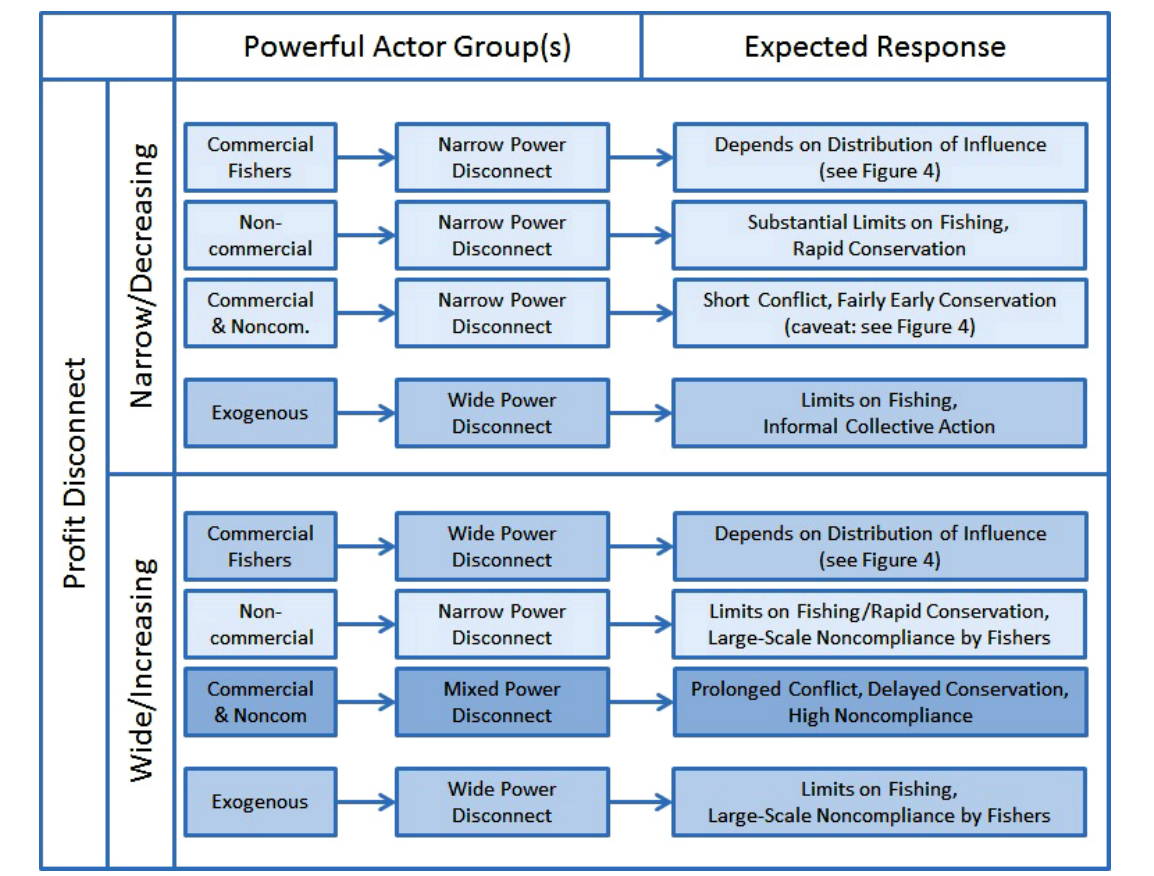
Fig. 3 . General power/profit dynamics.